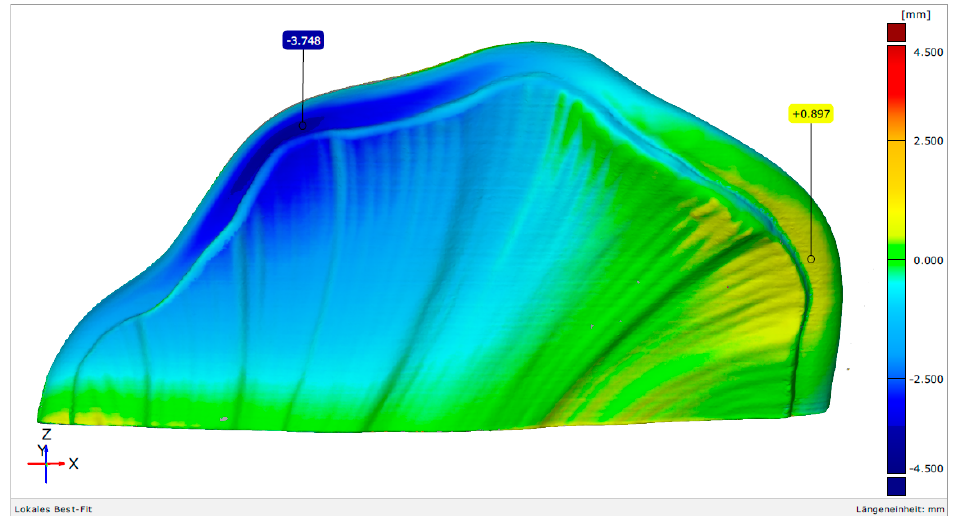
Figure 14. Superimposed fragment 1: manufacturing direction: clockwise; solvent debinded.